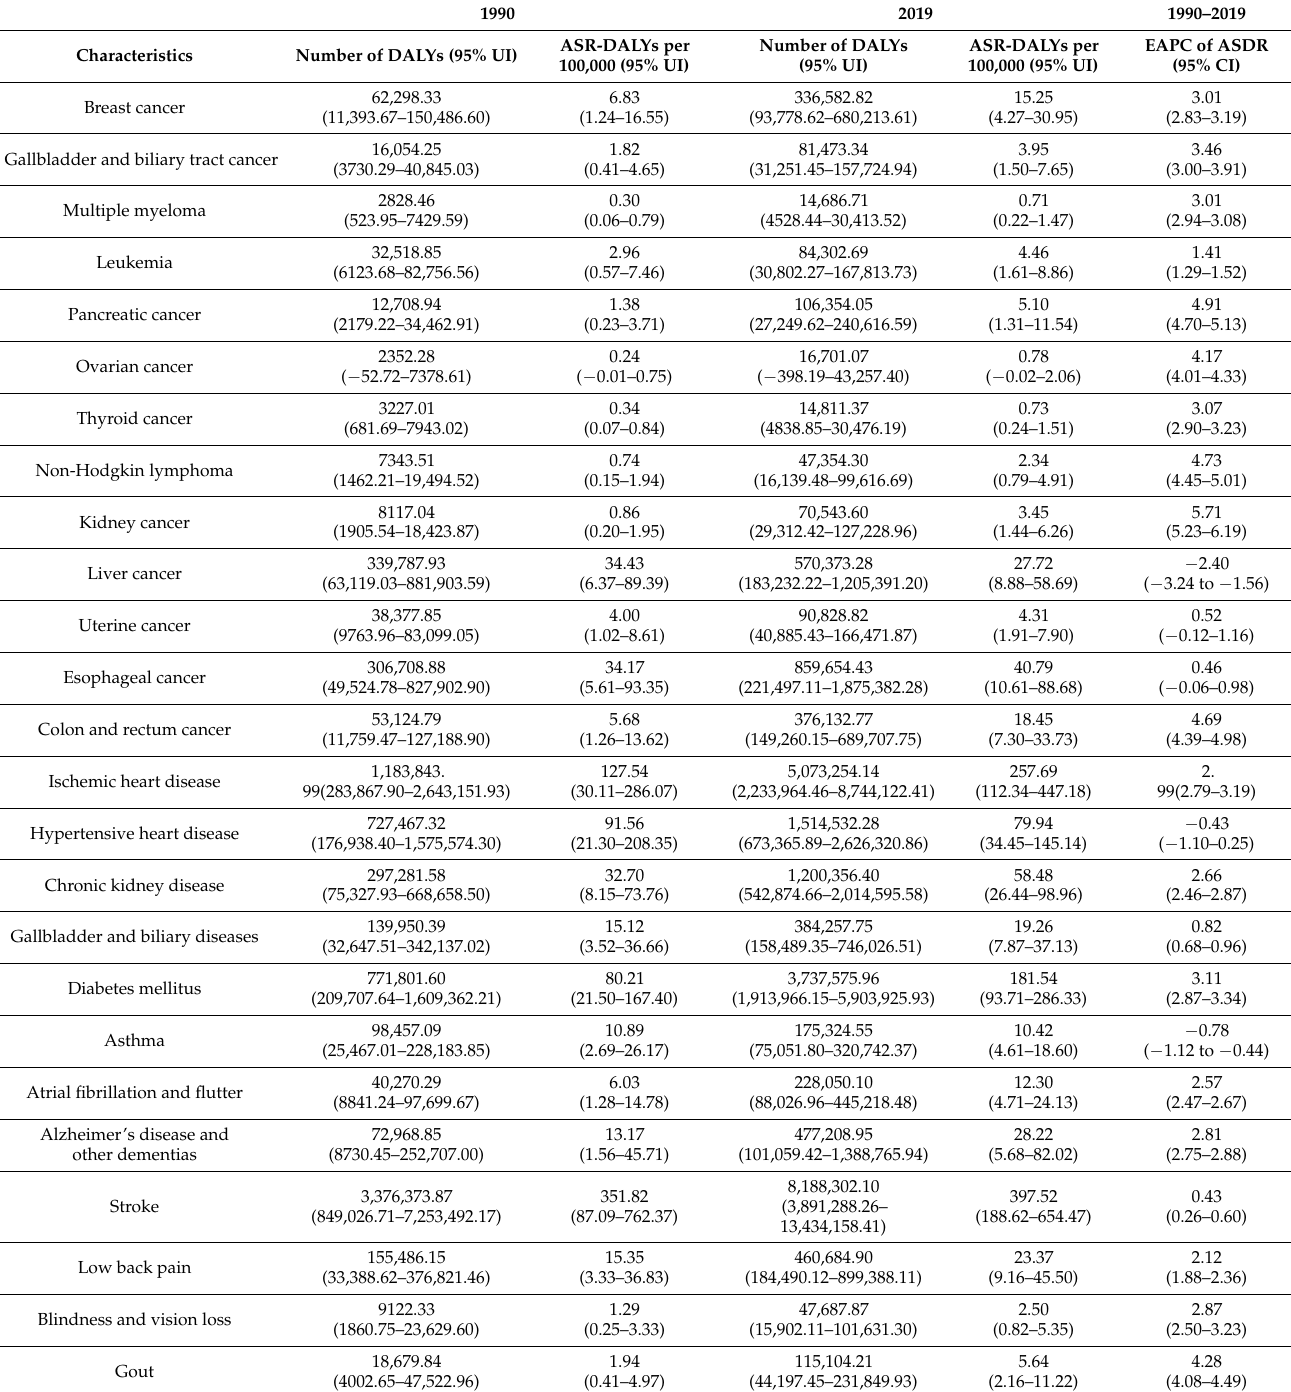
Table 2. The number of DALYs and ASR-DALYs in those with high BMI in 1990 and 2019, and their temporal trends from 1990 to